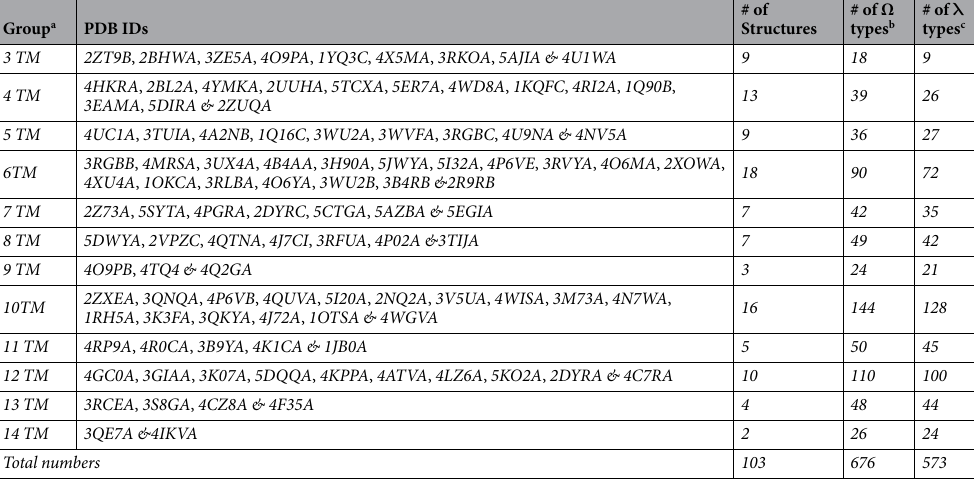
Table 1. Selected non-homologous helical membrane protein structures, their PDB IDs, and number of Ω type and λ type dihedral angles used in this study. All protein names and their classifications used in this work are described in the Supplementary Information Table S5. a Group was categorized according to the TM helical numbers in the proteins. b Total number of Ω type angles in the group. c Total number of λ type angles in the